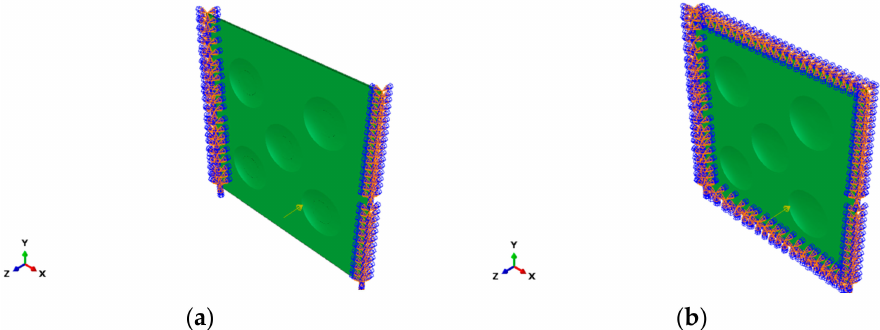
Figure 5. Two boundary conditions in this work: ( a ) BC 1: left and right edges of the plate are fixed, ( b ) BC 2: all edges of the plate are